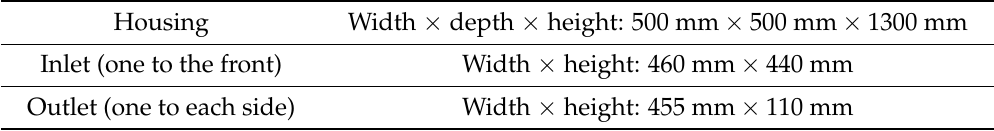
Table 1. Air cleaner